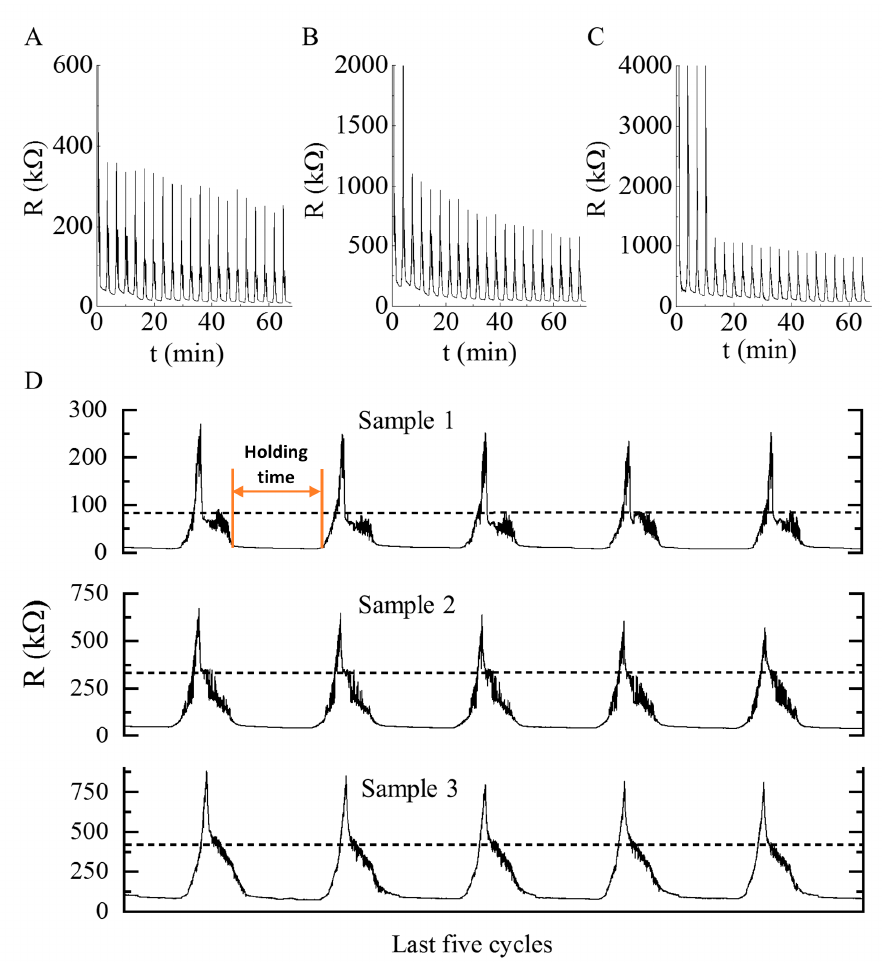
Figure 6. Cyclic pressure tests of ( A ) sample 1, ( B ) sample 2, ( C ) sample 3 flexible piezoresistive N-BCNT/PU-silicone rubber nanocomposites, and ( D ) recoverability tests of the samples.